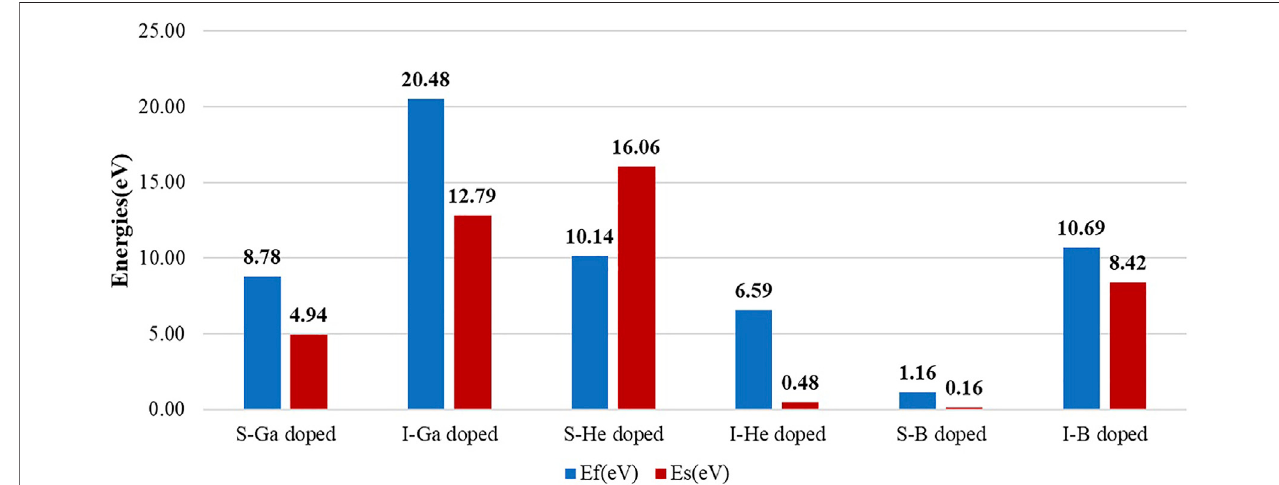
FIGURE 3 | Formation and strain energies for doped diamond materials.